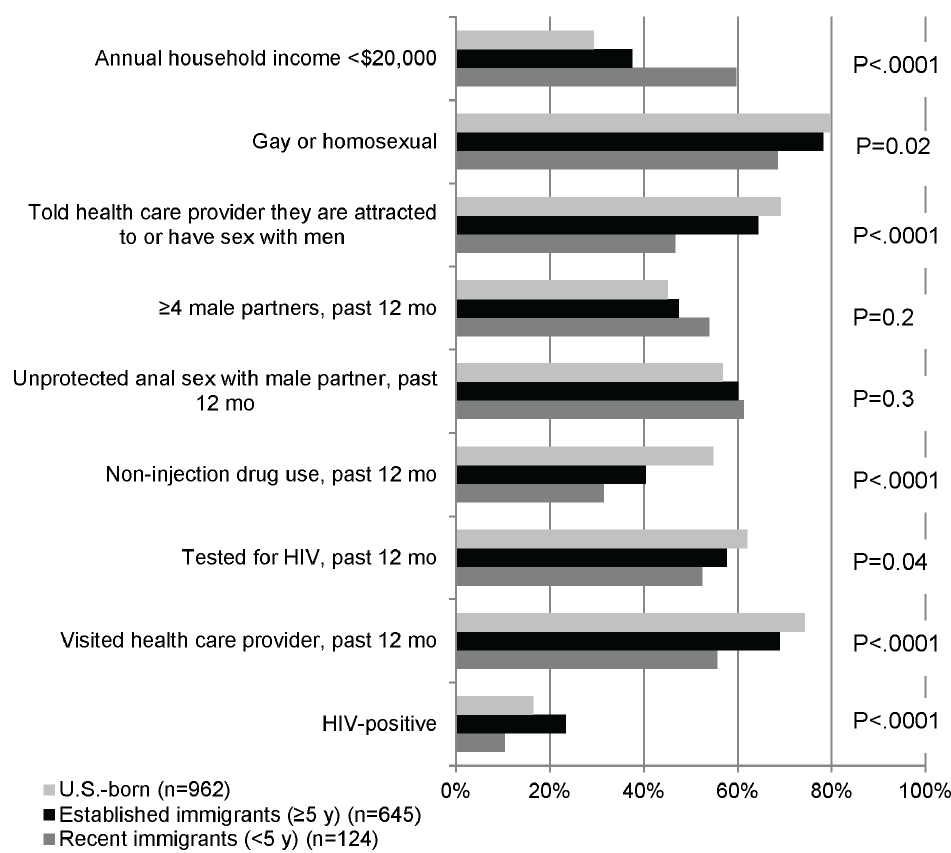
Figure 1. Characteristics of Latino MSM by location of birth and time since arrival, 20 U.S. cities.